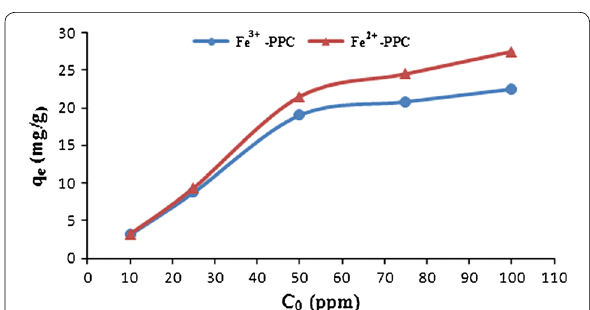
Fig. 4 The effect of initial concentration on adsorption capacity. The change of adsorption capacity in removal of Pb 2 + vs initial concen- tration of Pb 2 + for Fe 2 + -PPC is depicted in red and for Fe 3 + -PPC is depicted in blue